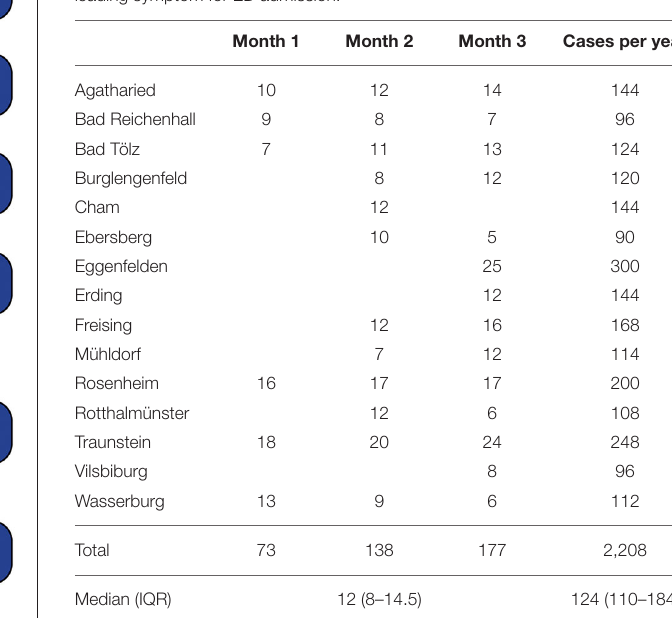
TABLE 1 | Number of cases per hospital and evaluation month with acute ( < 72h from onset) dizziness, vertigo, or imbalance of unknown cause (ADVIUC) as a leading symptom for ED